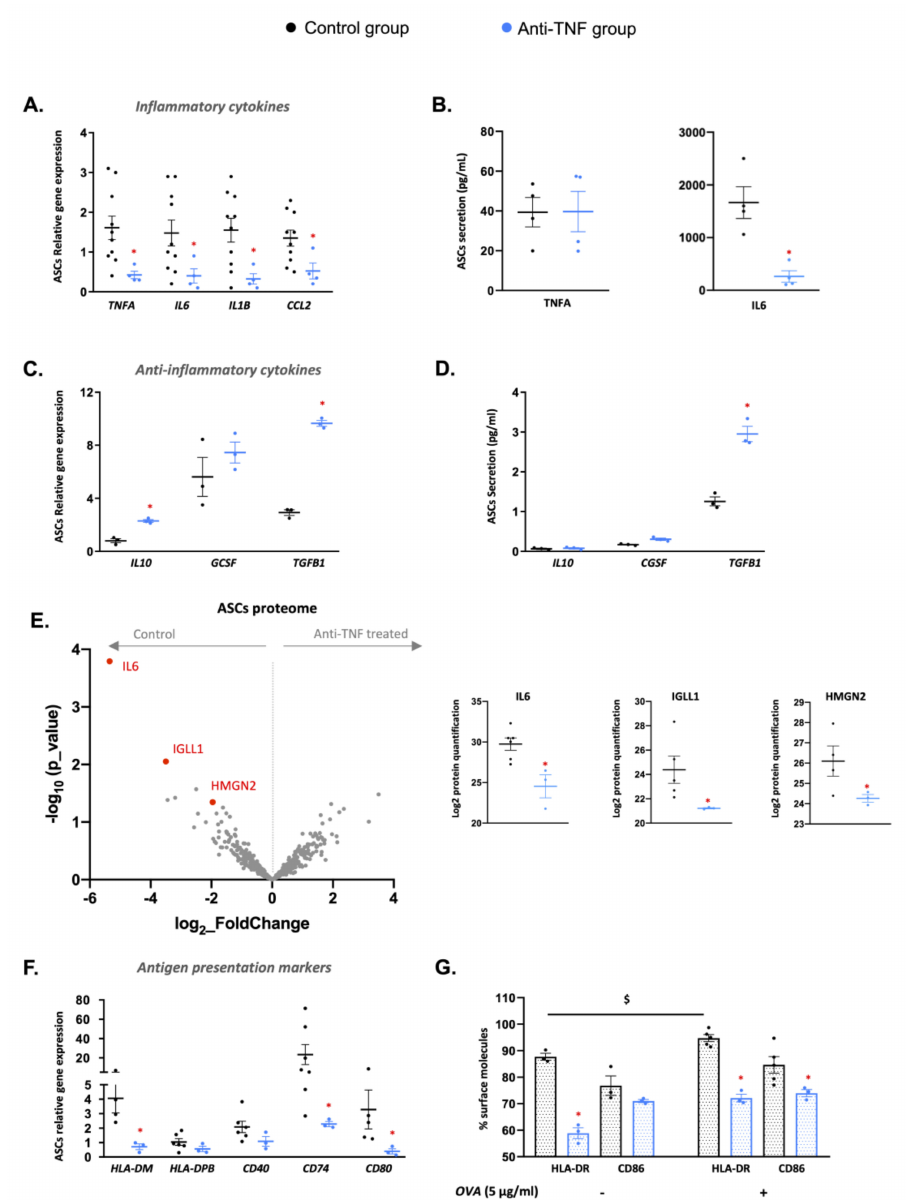
Figure 3. Anti-TNF therapies modify the inflammatory status of creeping fat-derived ASCs. ( A ) Gene expression of pro-inflammatory genes ( TNFA , IL6 , IL1B , and CCL2 ) in adipose-stem cells (ASCs) and ( B ) TNFA and IL6 abundance in 24 h conditioned medium of ASCs from patients treated with anti-TNF or control group. ( C ) Gene expression of anti-inflammatory genes ( IL10 , CGSF , and TGFB1 ) in ASCs from patients treated with anti-TNF or control group. ( D ) TGFB1 protein abundance in 24 h conditioned medium of ASCs from patients treated with anti-TNF or control group. ( E ) Analysis of the ASC protein secretome and protein abundance differences between ASCs isolated from control group (n = 6) and anti-TNF-treated group (n = 3). ( F ) Gene expression of antigen-presentation markers ( HLA- DM and HLA-DPB ) and co-stimulatory molecules ( CD40 , CD74 , and CD80 ) in ASCs from patients treated with anti-TNF or control group. ( G ) ASCs isolated from patients treated with anti-TNF or control group co-cultured or not with ovalbumin (OVA) were stained with a panel of antibodies and analyzed by flow cytometry to compare the percentage of surface expression of antigen-presenting markers. Results are shown as mean ± SEM from independent donors’ experiments. * p < 0.05 vs. control group. $ p < 0.05 control group without OVA vs. control group with